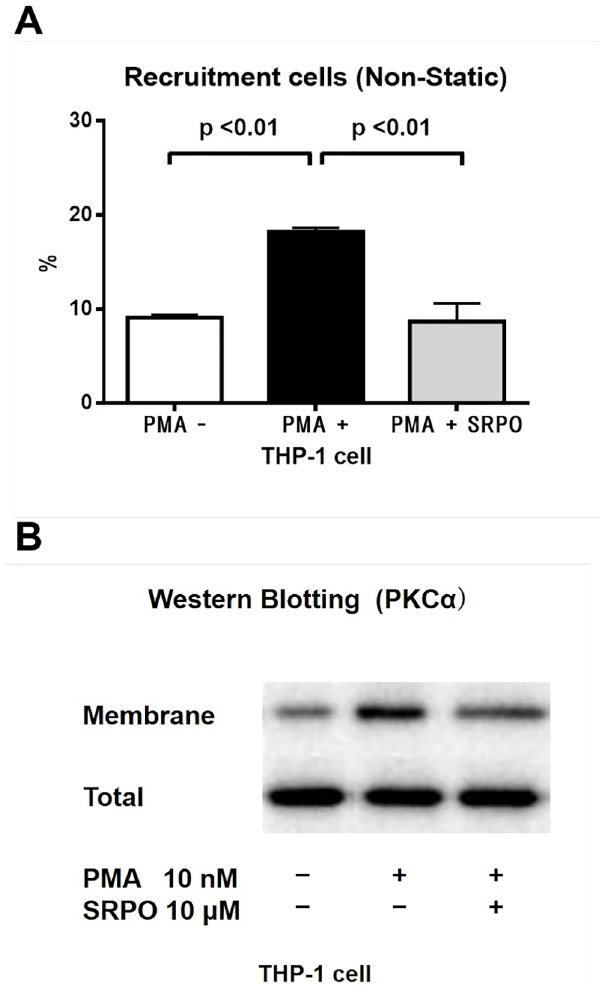
Fig 4. THP-1 cell adhesion to HUVECs (Non-static rotational assay) and expression of PKC α in THP-1 cells. (A) SRPO significantly reduced PMA-triggered THP-1 cell adhesion to the HUVECs. THP-1 cells were pretreated with SRPO (10 μ M) for 1 h and stimulated with PMA (10 nM) for 10 min before the assay. Preliminary experiments with trypan blue staining demonstrated that THP-1 cells were not damaged by SRPO (10 μ M, 1h) treatment (data not shown). Adhesion assays were performed as described in Materials and Methods. Data are the mean ± SD of three independent experiments in each group. (B) SRPO attenuated PMA-induced PKC α activation in THP-1 cells. THP-1 cells were incubated in the presence or absence of SRPO (10 μ M) for 1 h and stimulated with PMA (10 nM) for 10 min before the assay, and membrane proteins and total PKC α protein were detected by immunoblotting. Data are representative of three independent